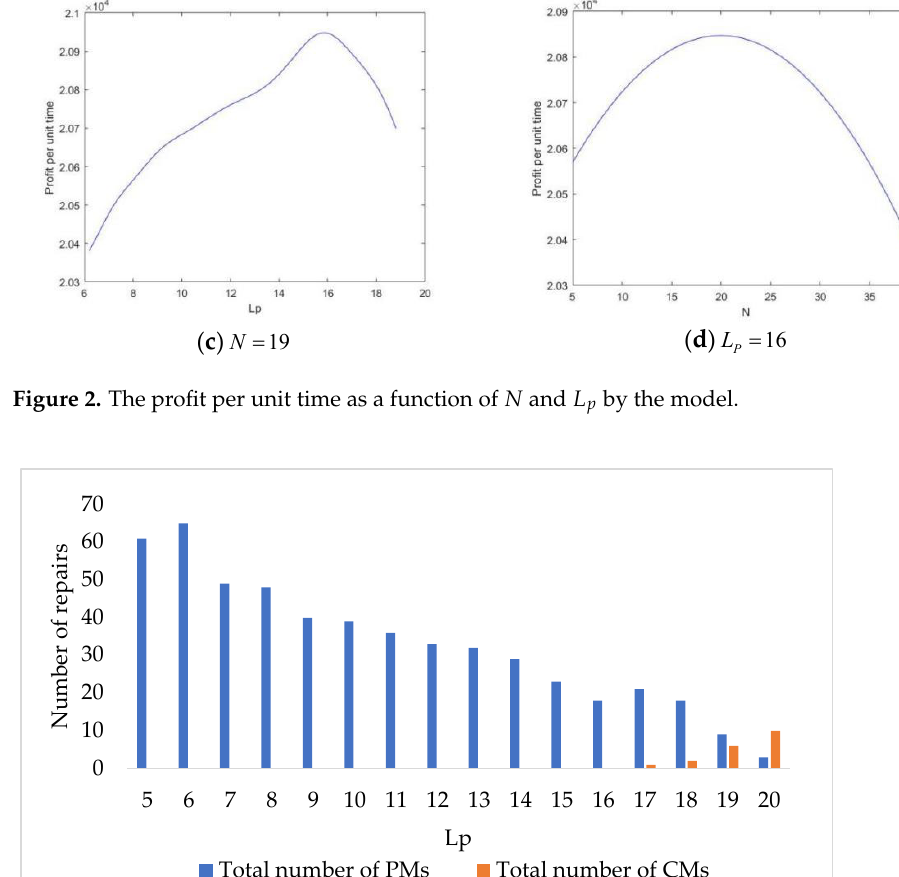
Figure 3. When 19 N = ,